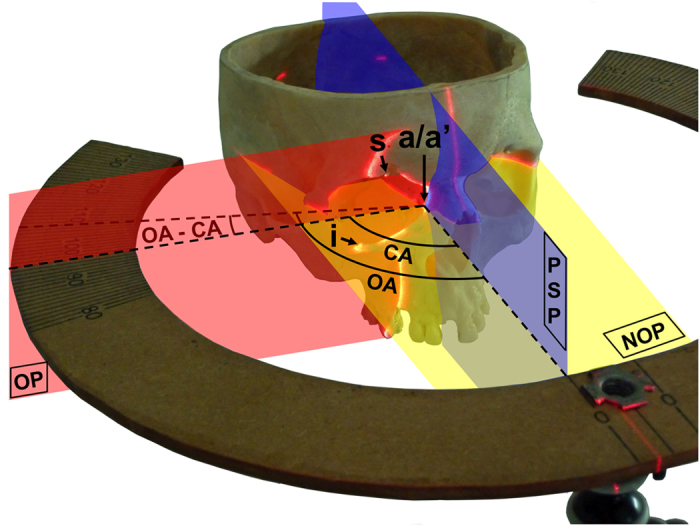
Overview of the convergence angle and opening angle.The sagittal plane and the neuro-ocular plane (NOP: yellow) are represented by a cross-laser. The protractor is positioned in the NOP. The most anterior point of the orbital margin is denoted by a. The point where the NOP crosses the inner orbital margin is denoted by a’. In this skull, points a and a’ coincide. The highest and lowest orbital points are denoted by s and i respectively. The orbital plane (OP) crosses points i, s and a. Its position is shown using a red line for laser crossing points i, s and a. The para-sagittal plane (PSP) is parallel to the sagittal plane and crosses points a and a’. The CA is the angle between OP and PSP, measured using the protractor. The OA is the maximum angle allowing point a’ to be illuminated by the line laser placed postero-laterally in the NOP. The difference between the CA and the OA is denoted by “OA-CA”.